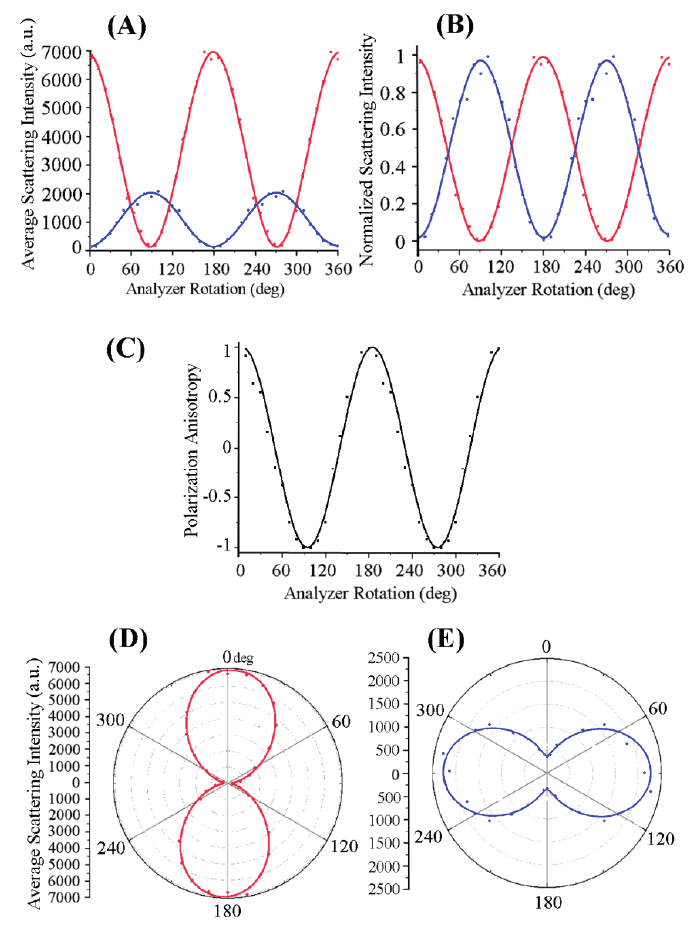
Figure 3. The NR-position dependent scattering signals under the two excitation conditions of E ║ and E ┴ were collected over the entire length of the ZnO NR ║ and plotted against the analyzer rotation. Red and blue symbols in all graphs are the experimental data when excitation polarizations of E ║ and E ┴ were used, respectively. Lines represent curve fits for the corresponding set of data. ( A ) The position-dependent scattering signal was averaged over the entire length of the NR ║ and plotted as a function of the analyzer angle. For the same exposure of 50 ms, the overall scattering intensity from the same NR was much lower when E ┴ was used as excitation instead of E ║ . ( B ) The average scattering intensity was normalized with respect to the highest intensity values measured at each excitation condition and graphed as a function of the analyzer rotation. ( C ) Polarization anisotropy values calculated from the data shown in (B) follow a cos 2 θ dependence on the analyzer angle, θ . ( D,E ) Polar plots of average scattering intensities from the ZnO NR ║ under (D) E ║ and (E) E ┴ excitation are